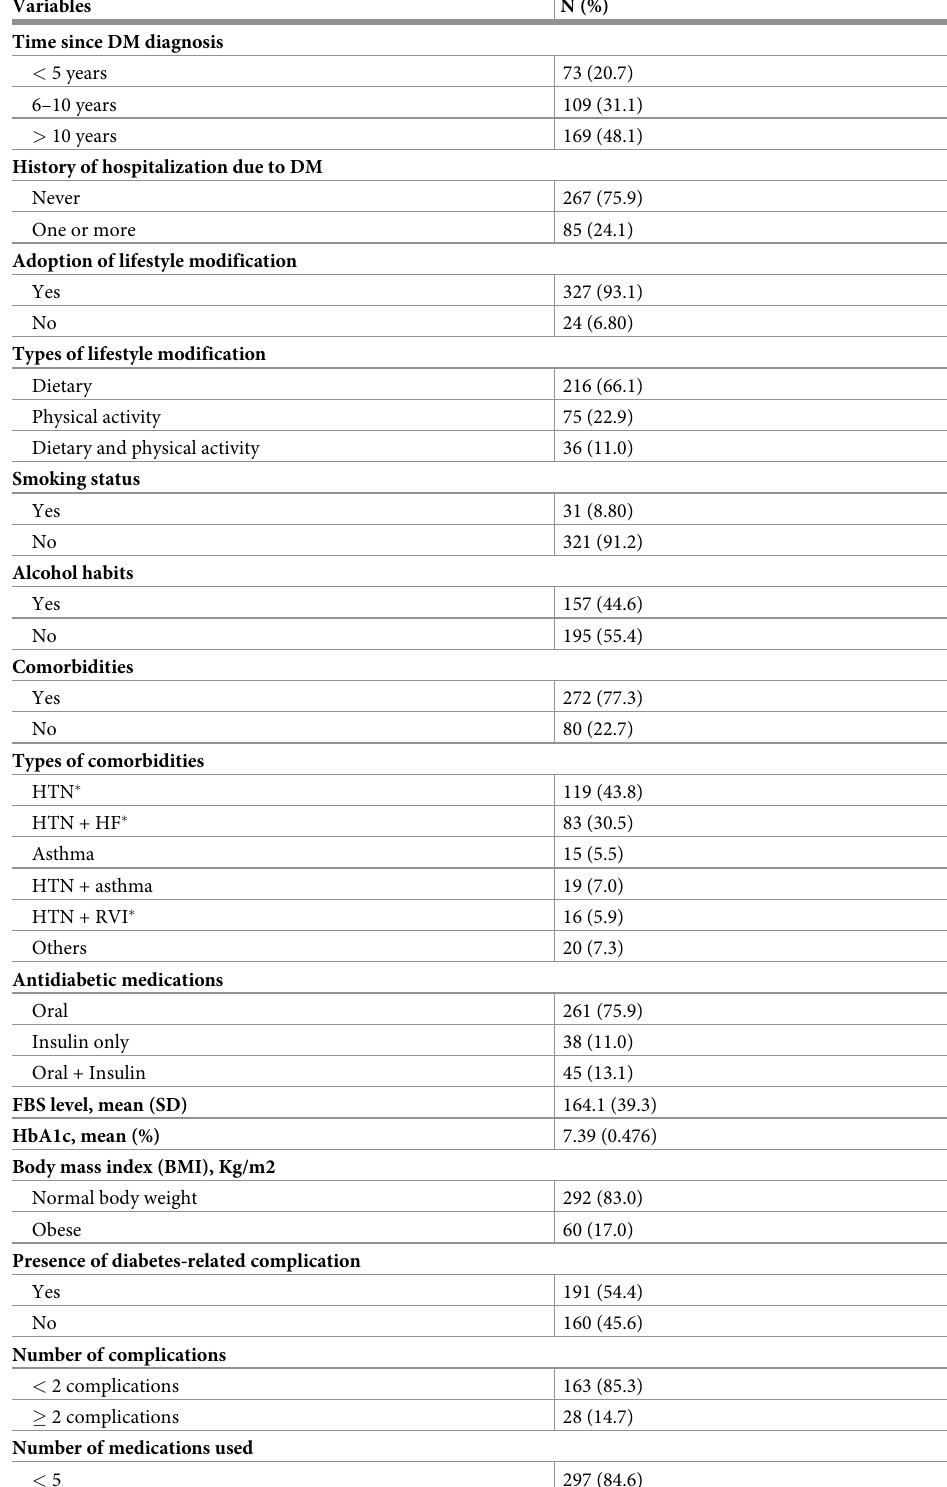
Table 2. Clinical characteristics of patients with T2DM (N =